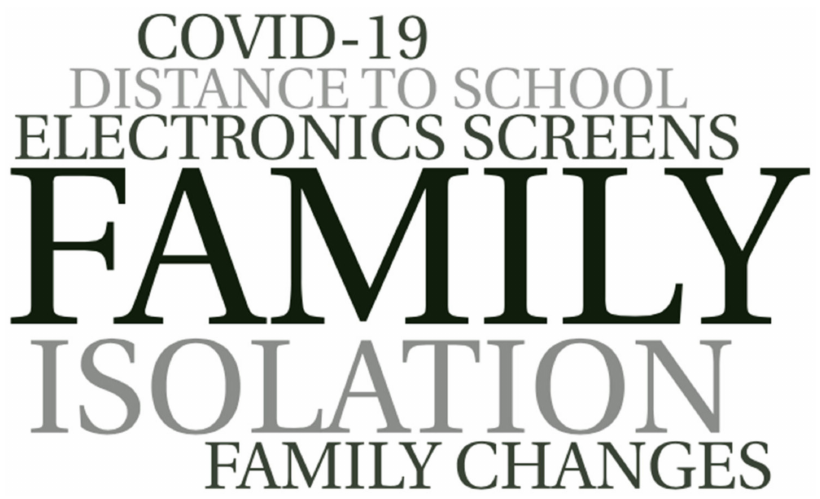
Figure 5. World cloud alluding to arguments in relation to family. Self-made